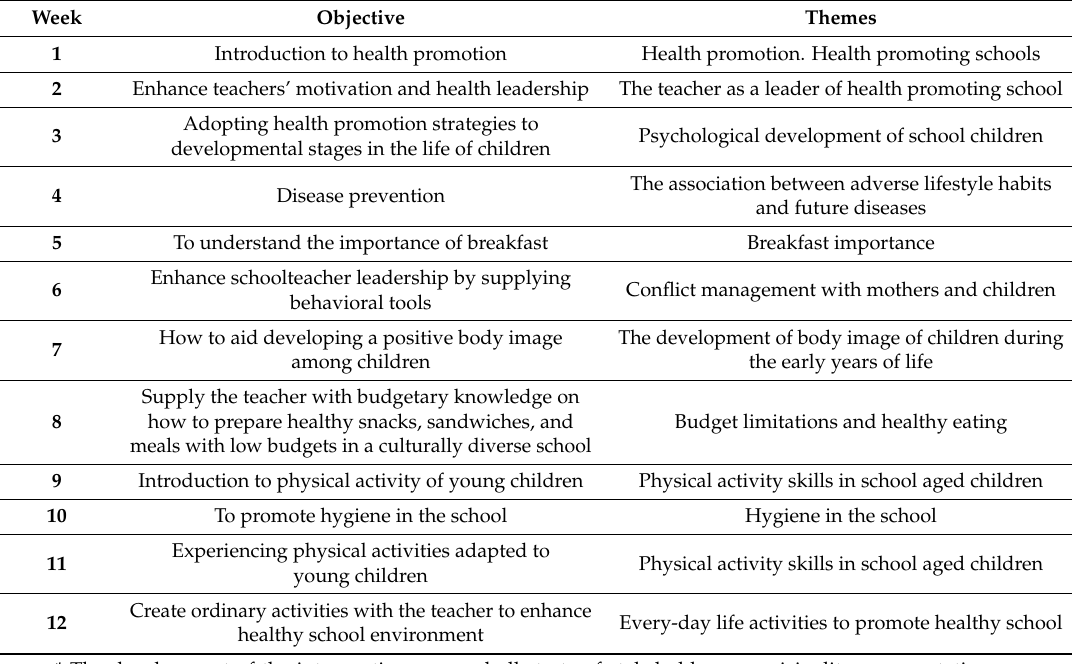
Table A2. School Teachers’ Intervention * (full model only, 60 h overall).